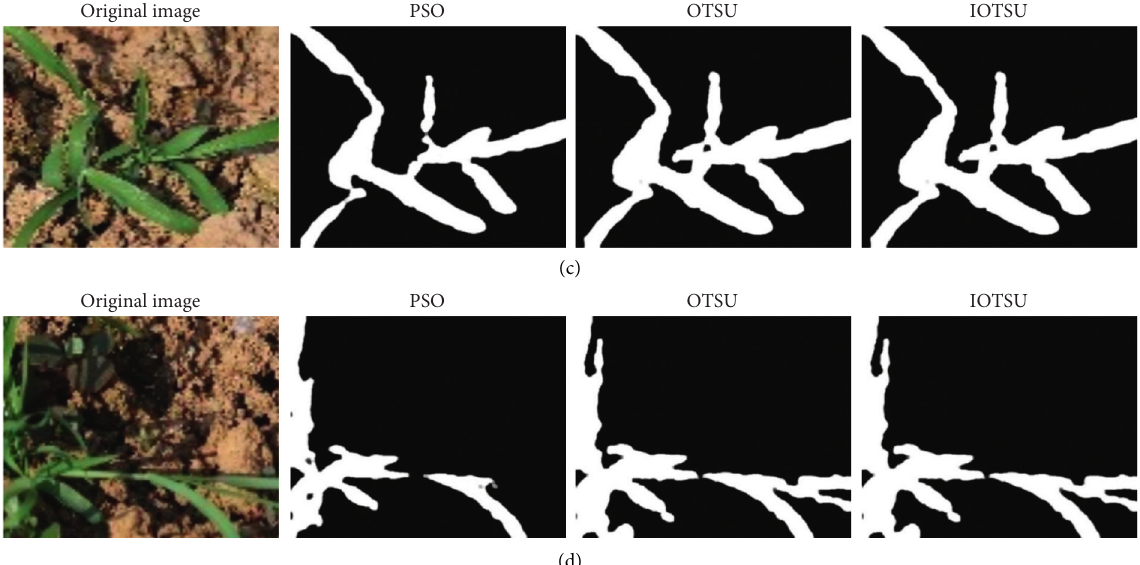
Figure 13: The results of segmentation using different algorithms. (a) and (b) Optimized results of corn binary image. (c) and (d) Optimized results of weed binary image. Table 3: Comparison of performance parameters using different segmentation algorithms. Algorithm